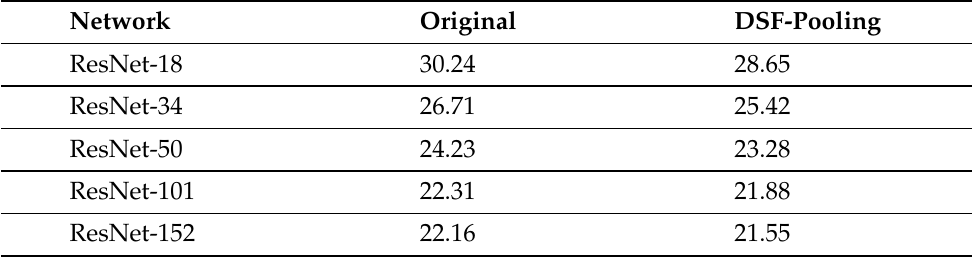
Table 2. Classification error rates (%) for ResNet variants on ImageNet